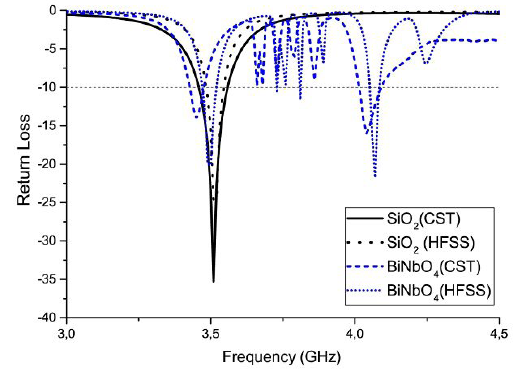
Figure 2. Antennas in black are simulated on CST Studio and Ansys HFSS with SiO substrate and in blue are simulated in CST Studio 2 and Ansys HFSS with BiNbO substrate. 4